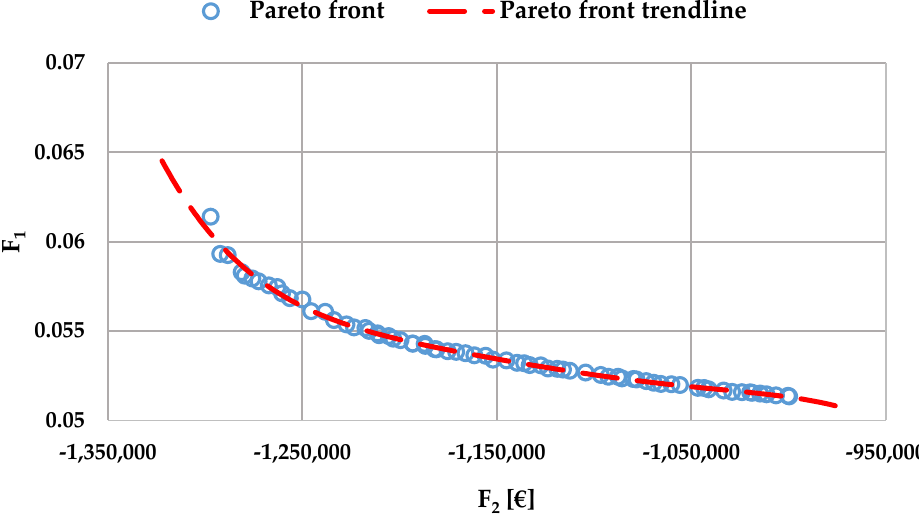
Figure 8. Pareto front for the monthly operation of the storage.